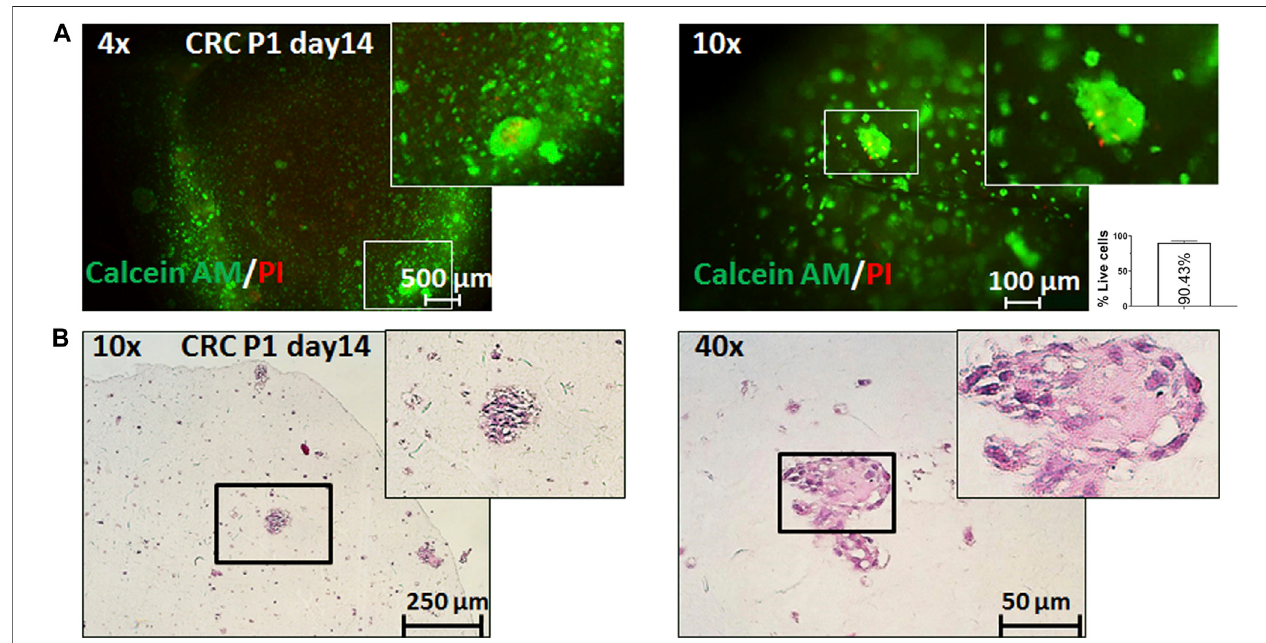
FIGURE 4 | 3D bioprinting of primary CRC samples. Representative pictures of 3D bioprinted primary CRC cells taken on day 14 after printing. (A) Live/dead staining with calcein AM (live cells: green fl uorescence) and propidium iodide (dead cells: red fl uorescence) under × 4 and × 10 magni fi cation and relative quanti fi cation of percentage livecells (per 1 mm 2 ).Error bars representSD of themean from at least twoimages. (B) Representative pictures ofthehematoxylin and eosin (H&E) staining of sections from 3D bioprinted primary cells under × 4 and × 10 magni fi